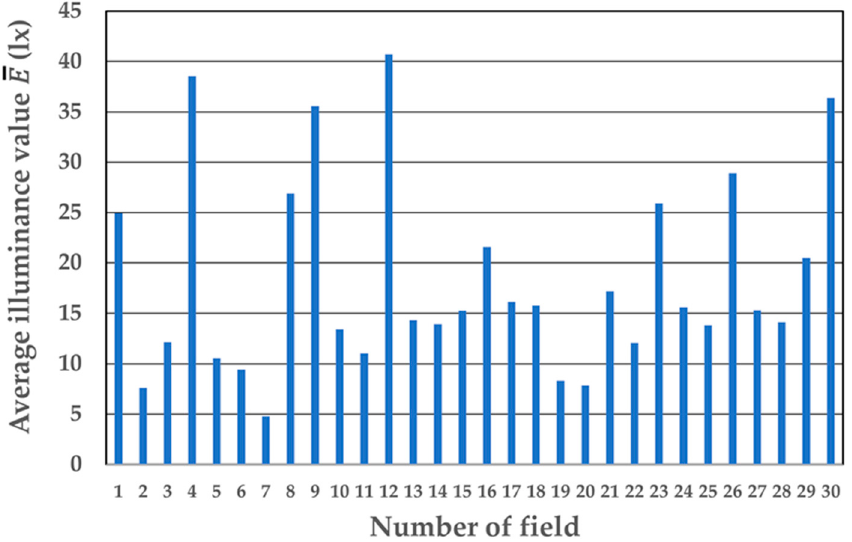
Figure 11. Mean illuminance values 𝐸(cid:3364) (lx) in the design fields.